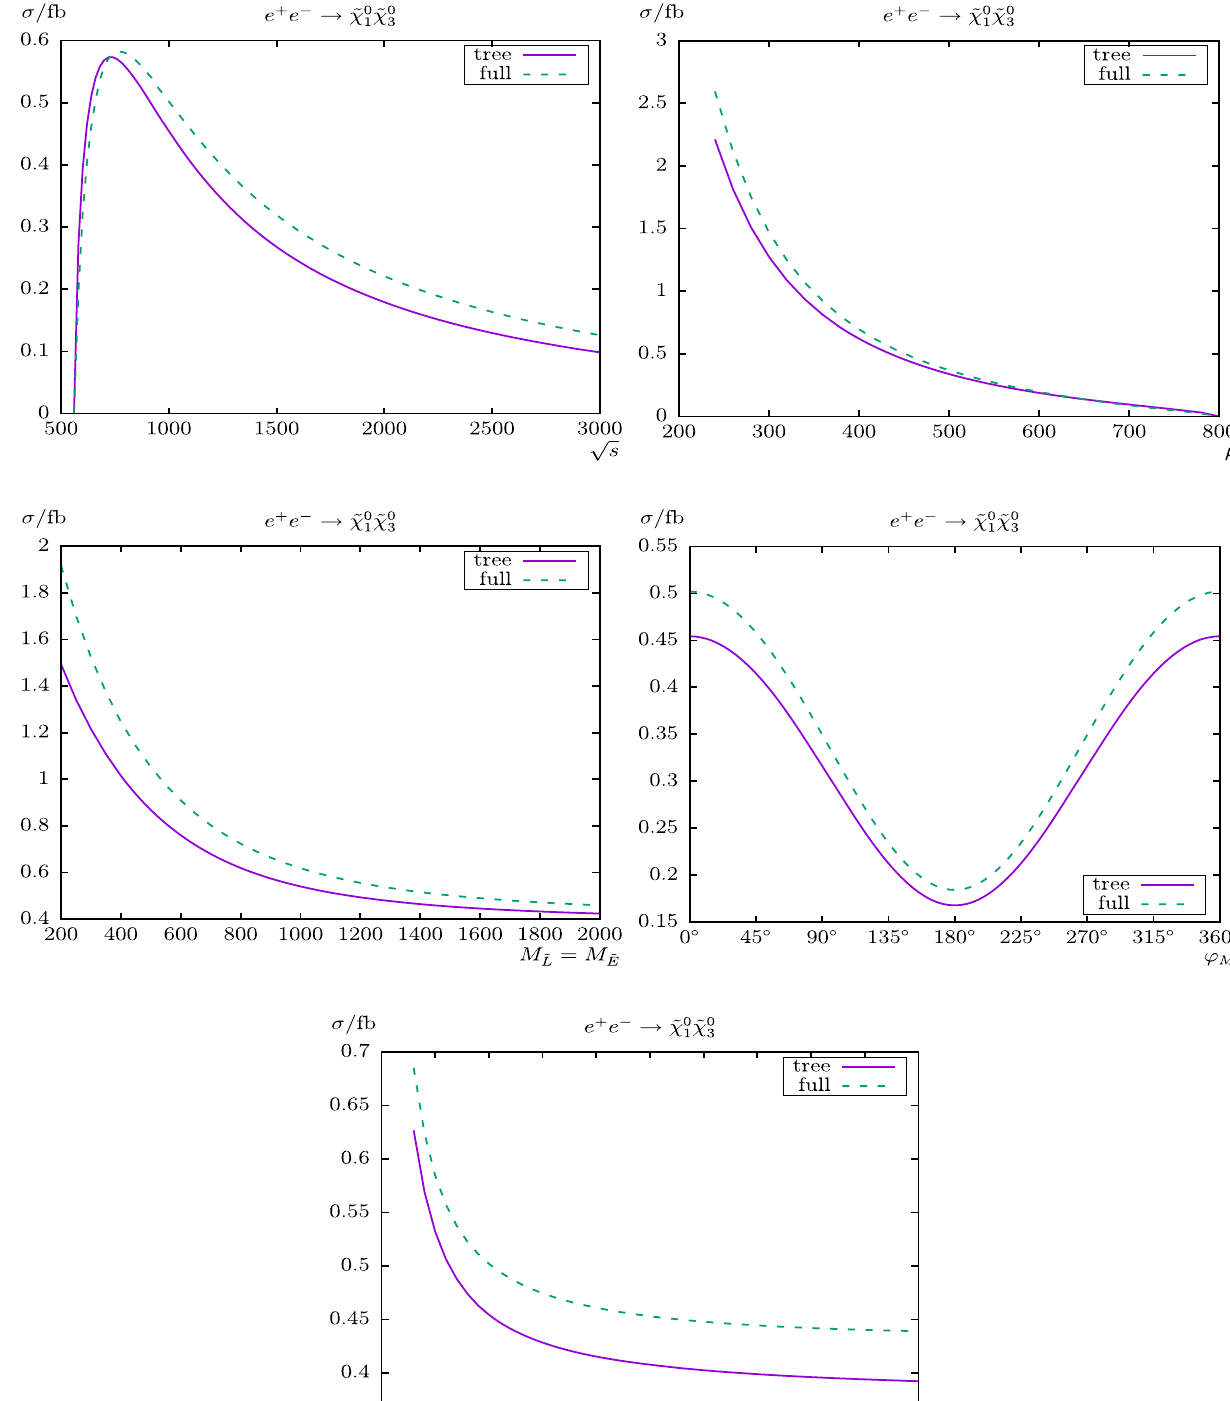
˜ χ 0 ) . Tree-level and full one-loop corrected 1 3